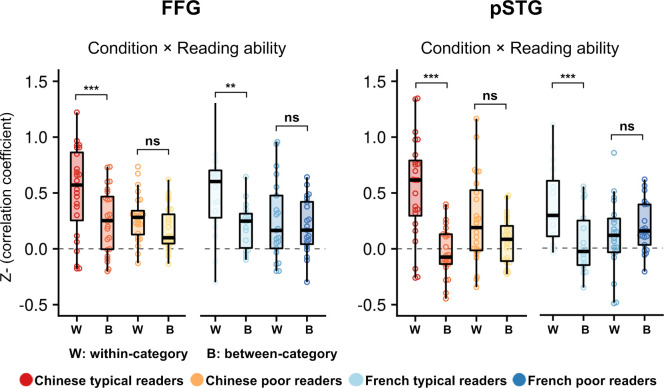
Multivariate pattern analysis indicating that the word-induced activation is less reproducible in poor readers.Within the designated ROIs, we computed the correlation coefficient of the multivoxel patterns for the word versus fixation contrast in run 1 and in run 2 (within-category correlation). For the between-category coefficient, the plots show the average correlation coefficient between words and faces, words and houses and faces and houses between run 1 and run 2. In each plot, the correlation is presented for the Chinese children on the left of the plot and for French children on the right. The words ‘Condition × Reading ability’ indicate a significant interaction between condition (within vs. between) and the status of children (typical vs. poor readers) (after FDR correction for a total of 13 ROIs). Typical readers, but not poor readers, exhibited a significant similar pattern of activation to words from one run to the next in the left FFG and pSTG, suggesting that the weaker activation for words in poor readers was not due to greater anatomical variability in this group but was related to genuinely less reproducible activation patterns than in typical readers.Figure 5—source data 1.Correlation coefficients for within-category patterns and between-category patterns in each of the four groups and ROIs.